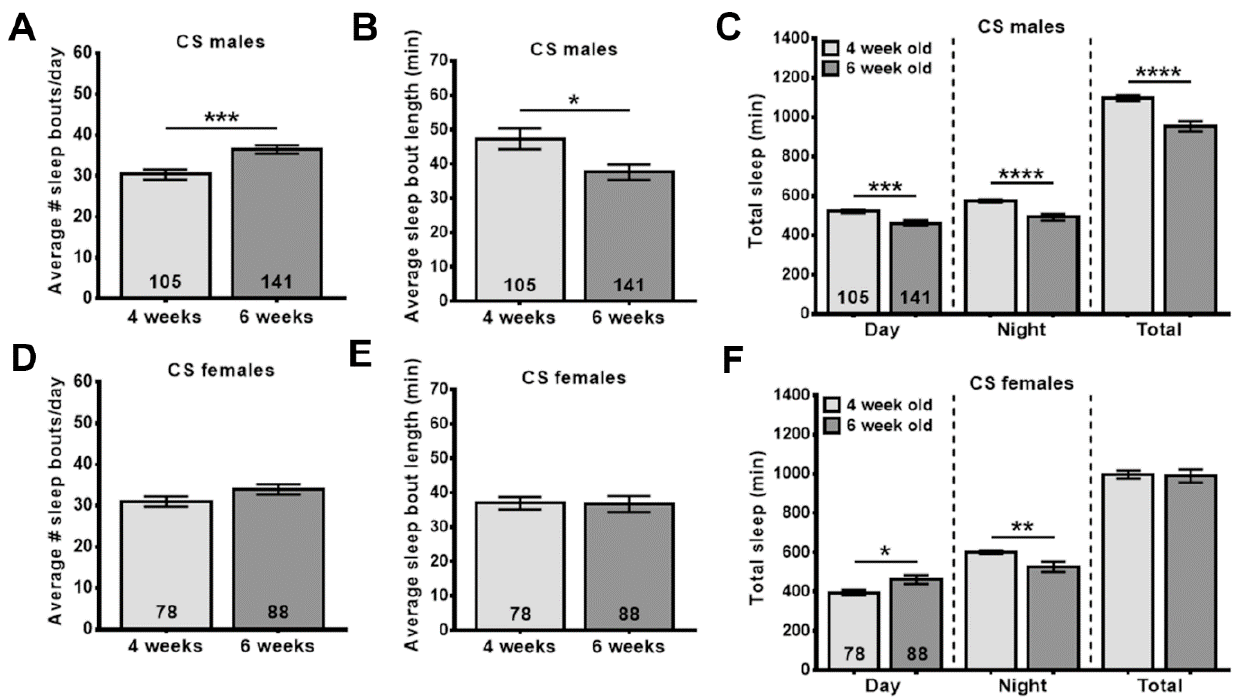
Figure 4. Aged flies show sleep disruptions. Additionally, 42-day-old males show a significant increase in sleep bout number ( A ) while sleep bout length is decreased ( B ) when compared to younger flies (28 d). ( C ) Both daytime and nighttime sleep is reduced in the older flies. 42-day-old females do not show significant changes in their sleep pattern, though the sleep bout number is slightly increased ( D , E ). However, 42-day-old female flies show decreased nighttime sleep compared to 28-day-old flies, whereas their daytime sleep is increased ( F ). Sleep was analyzed starting at the indicated age. The number of analyzed flies is given in the bars, and a Student’s t-test was used to determine significance. Bars represent means and error bars SEMs. * p < 0.05, ** p < 0.01, *** p < 0.001, **** p <